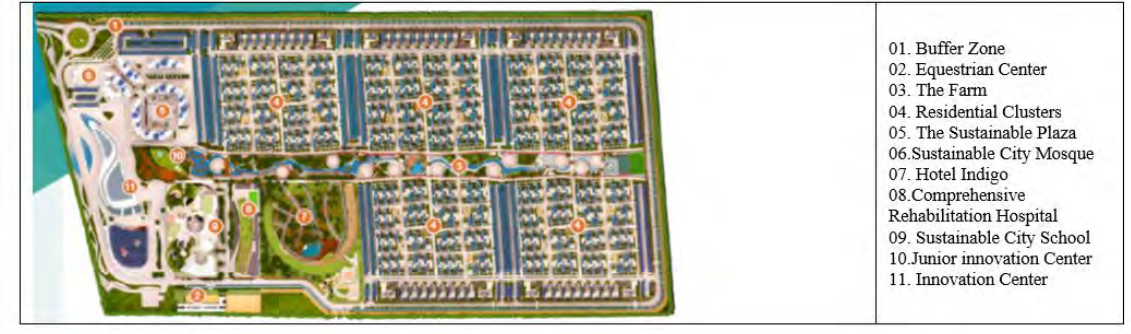
Figure 3. Master plan of the sustainablecity in Dubai (Diamond,